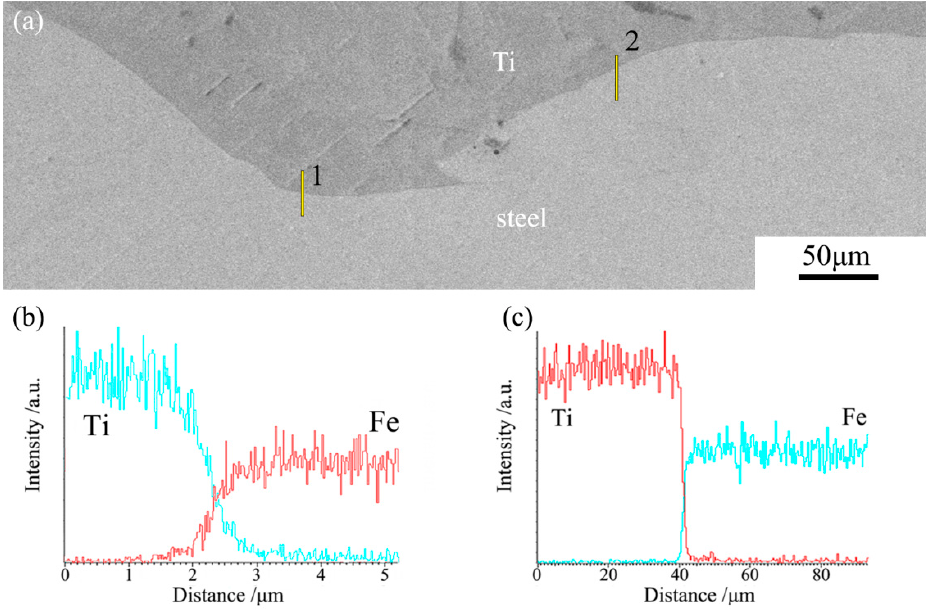
Figure 6. ( a ) Typical interface microstructure of TA1 / LAS composite plate and compositional profiles of Ti / steel interface in di ff erent regions from EDS: ( b ) at the trough of the wave (position 1), ( c ) at the crest of the wave (position 2).